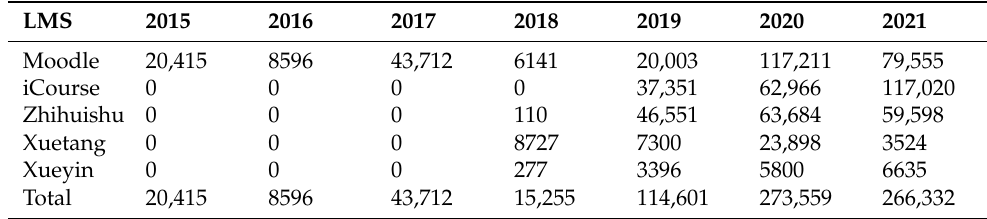
Table 3. Enrollment of S university’s BL courses based on